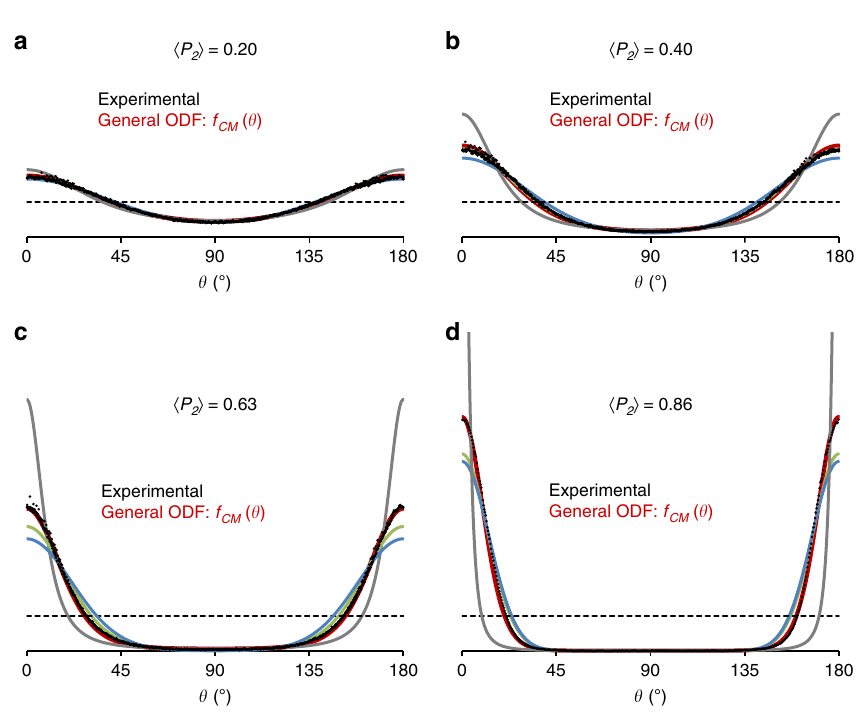
Fig. 5 Validation of the general orientation distribution function for clay minerals. Comparison between experimental ODFs (black circles) and predicted ODFs (red lines) using the general orientation distribution function for clay minerals ( f CM ( θ ) using Eq. (21)). The selected samples display a gradual increase in anisotropy value with a compacted kaolinite with 〈 P 2 〉 = 0.20, b compacted kaolinite with 〈 P 2 〉 = 0.40, c centrifuged kaolinite with 〈 P 2 〉 = 0.63, and d sedimented smectite ( fl uorohectorite) with 〈 P 2 〉 = 0.86. Isotropic organization is shown as a horizontal dotted line for reference. Conventional distribution models are shown in blue, green, and gray for the Fisher ( f F ( θ )), Bingham/Maier-Saupe ( f B/MS ( θ )), and mechanical compaction ( f MC ( θ )) models,